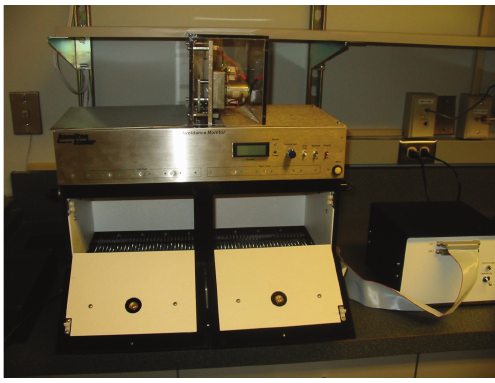
Figure 2: Passive avoidance: the mice are trained to avoid the pre- ferred dark compartment by paring it with an aversive